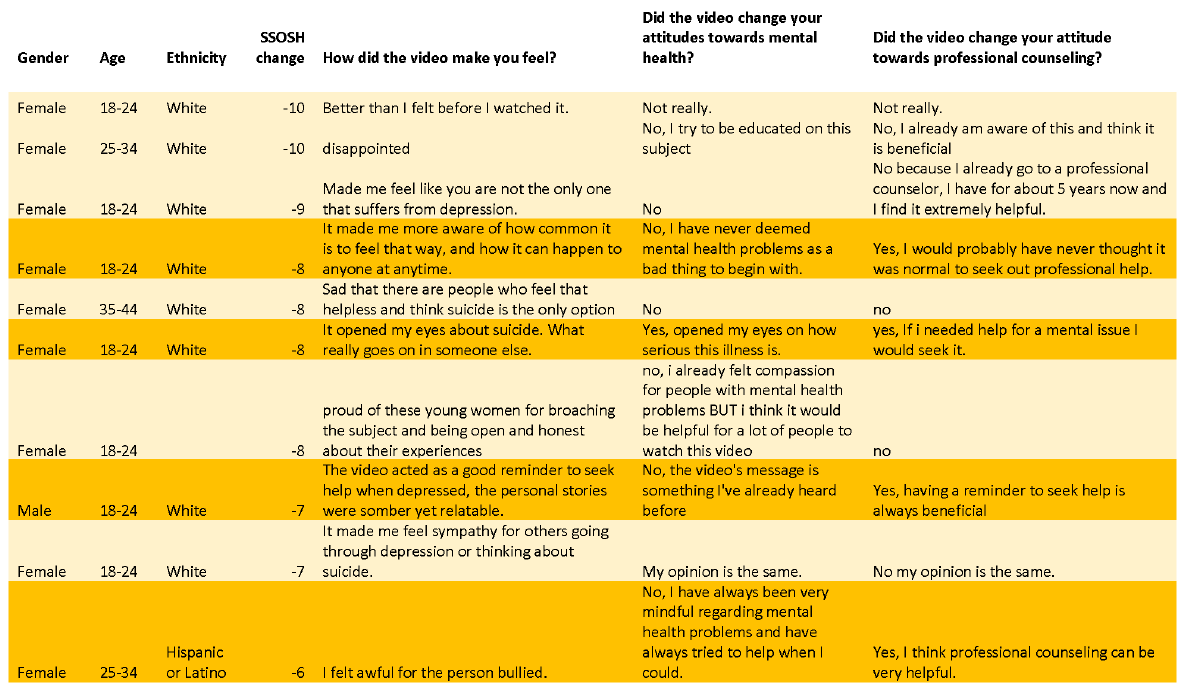
Figure 3. Plot of change in SSOSH against baseline SSOSH score for Study 2. The dashed line shows the greatest possible improvement for each baseline score. The horizontal line is the practically meaningful individual improvement cutoff at − 3.